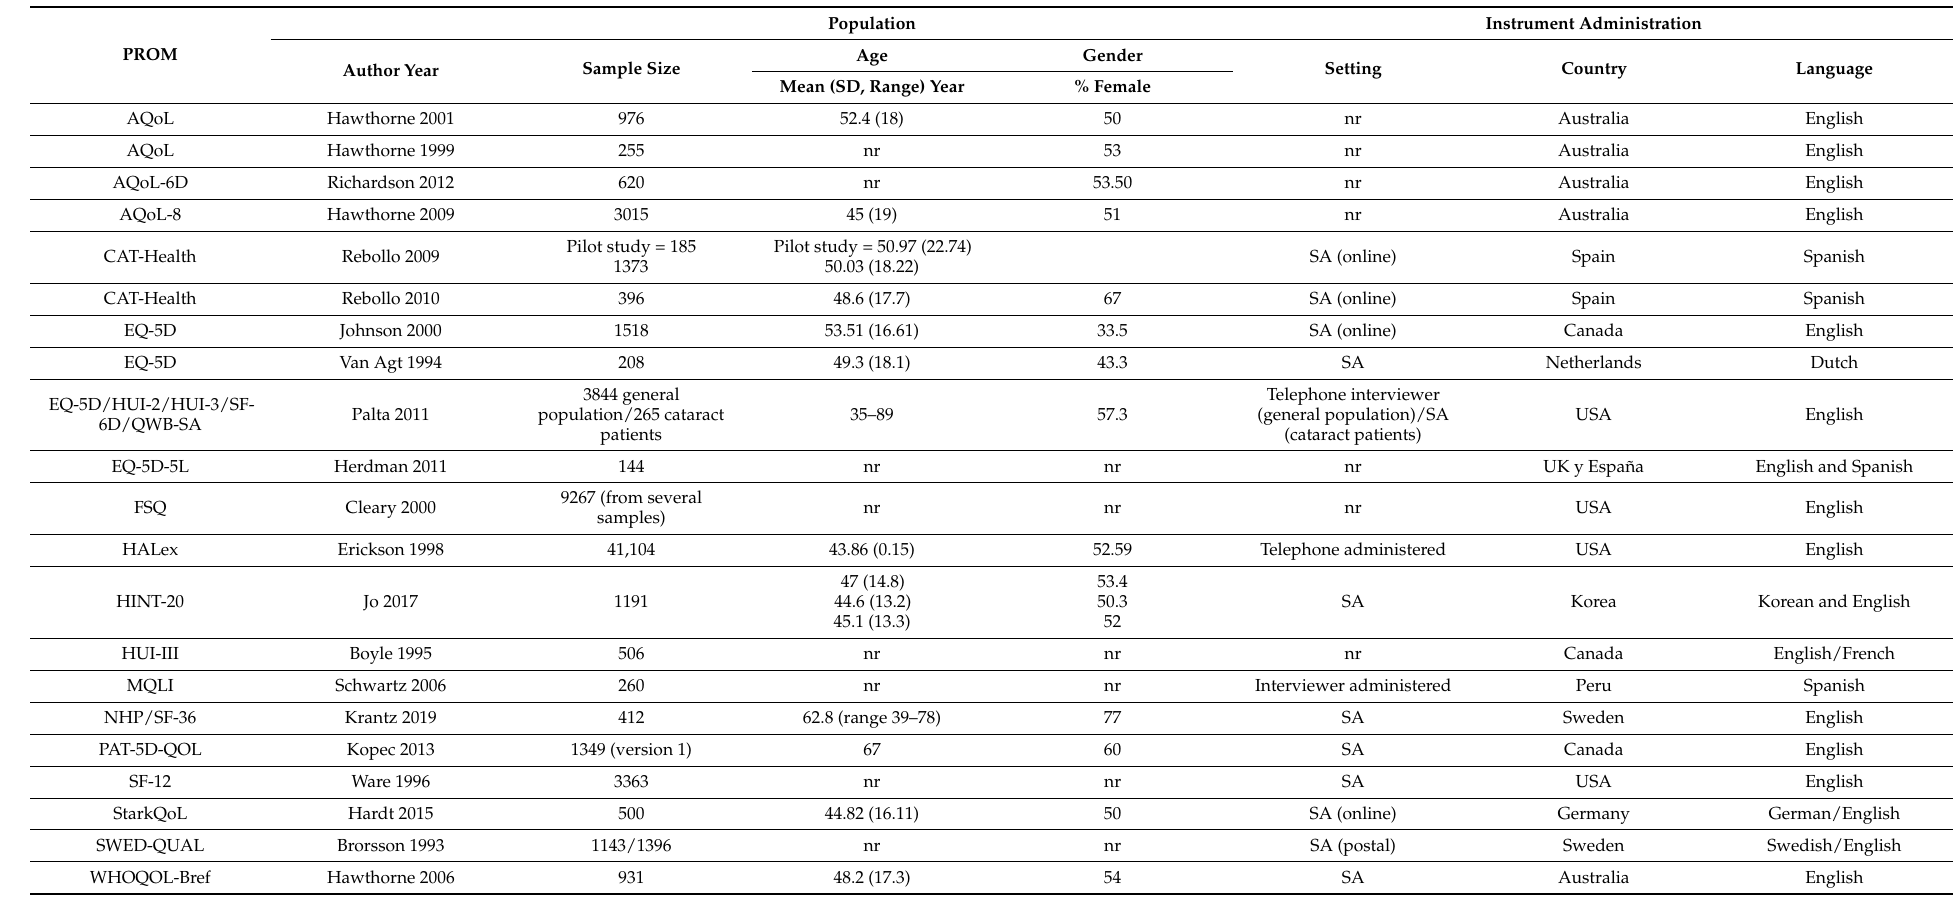
Table 3. Characteristics of the studies assessing the measurement properties of general HRQOL